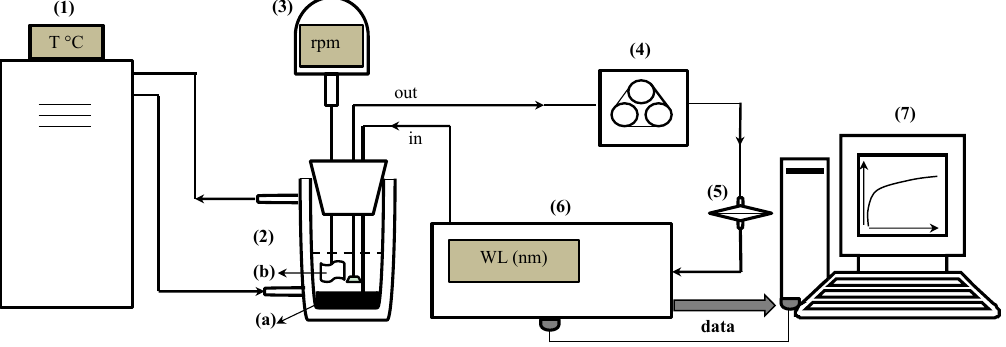
Figure 4. Experimental set ‐ up for the kinetic study. (1) PolyScience Digital temperature controller; (2) double jacket experimental reactor, (a) GAC, (b), propeller; (3) IKA mixer; (4) Heidolph Pumpdrive 5001 peristaltic pump (tubing size: 1.7 mm); (5) PTFE 0.45 ‐μ m filter; (6) Ultrospec 2000 spectrophotometer (1 ‐ cm quartz cuvette); (7) computer. WL = wavelength.